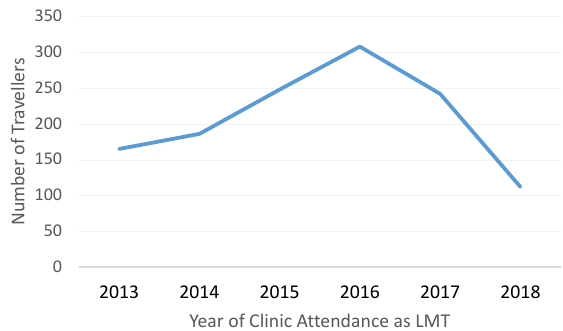
Figure 2 . Temporal Trends in Last-Minute Traveler Clinic Attendances.